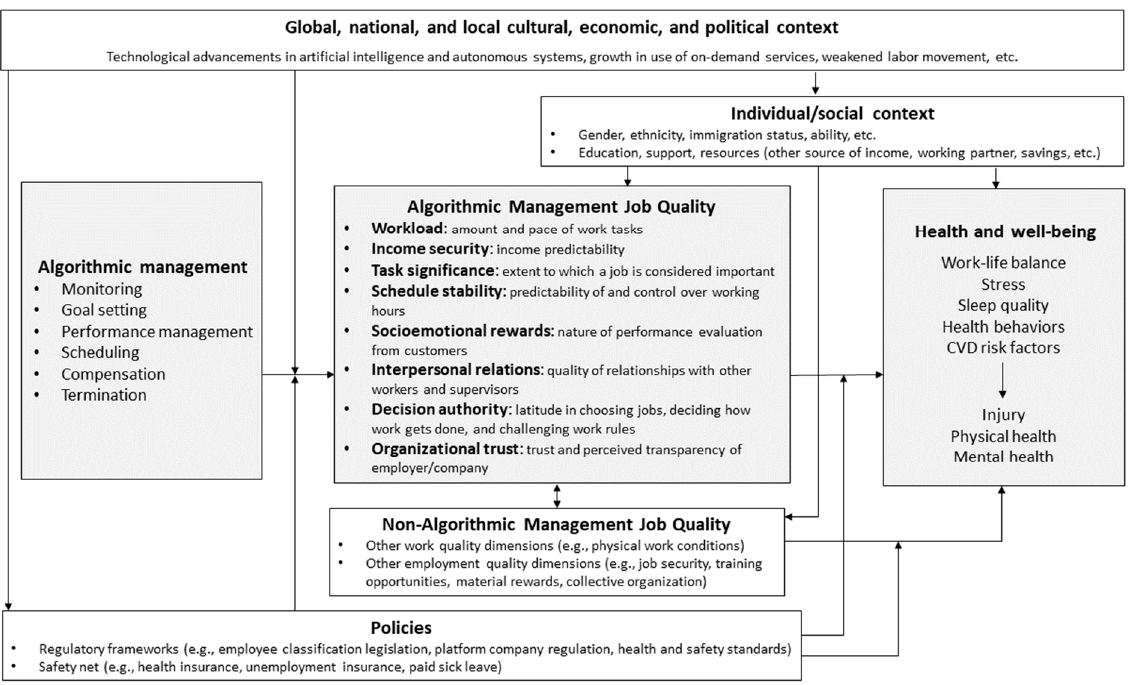
Figure 1. Health-related job quality dimensions influenced by algorithmic management.